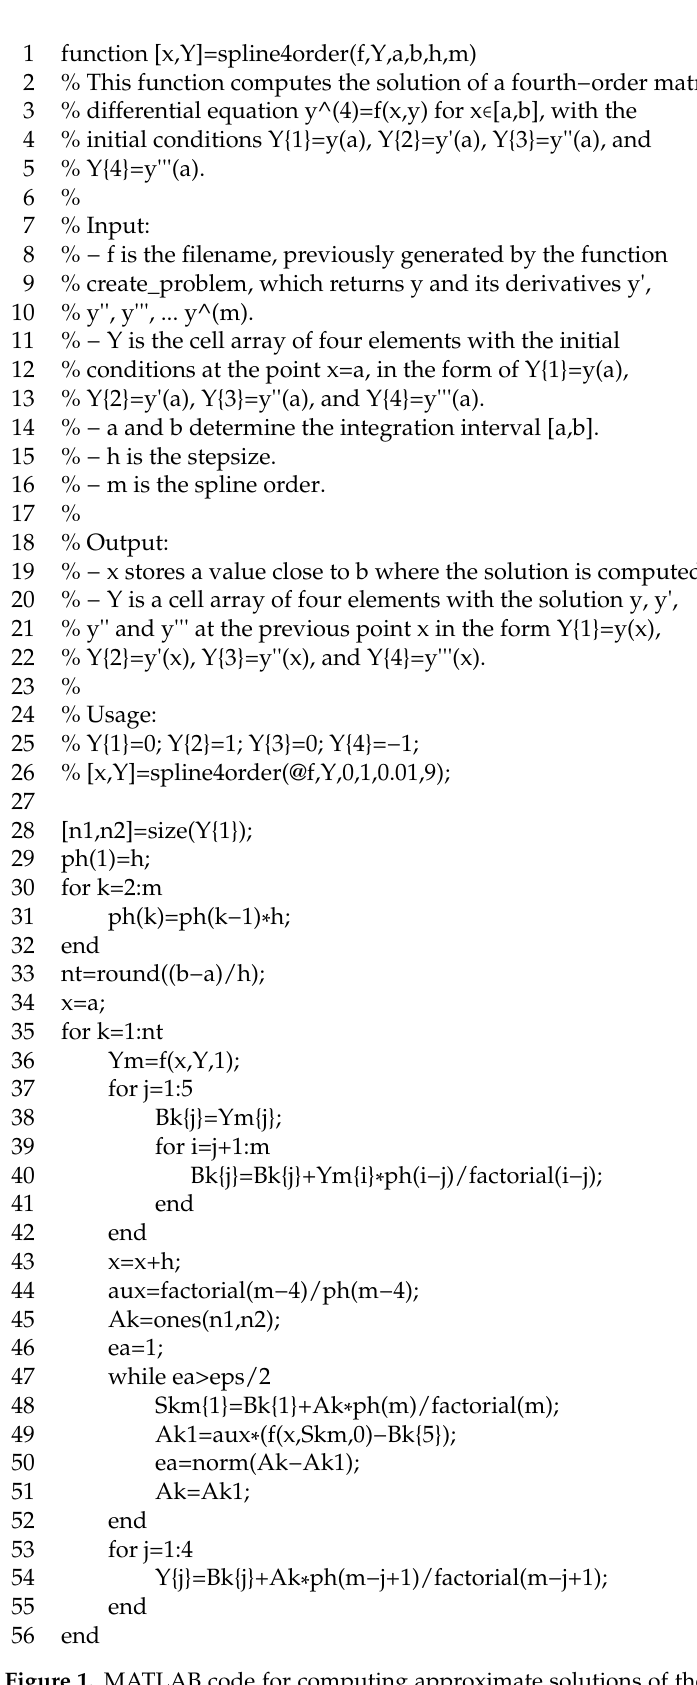
Figure 1. MATLAB code for computing approximate solutions of the problem in Equation (4) by means of m -th order splines.